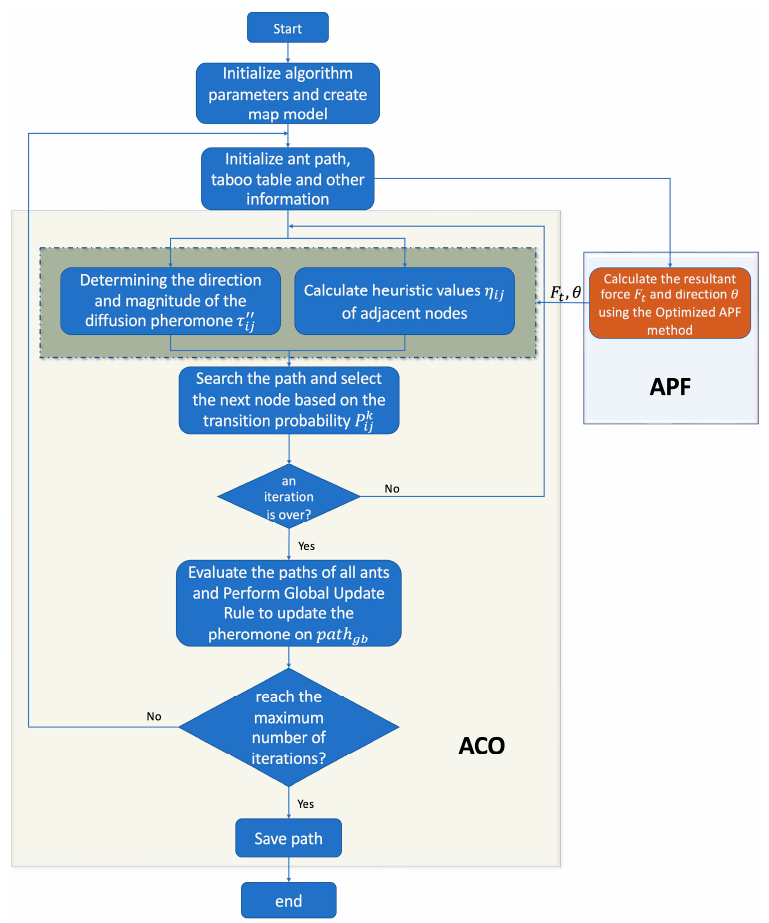
Figure 4. APF-ACO algorithm flow chart.